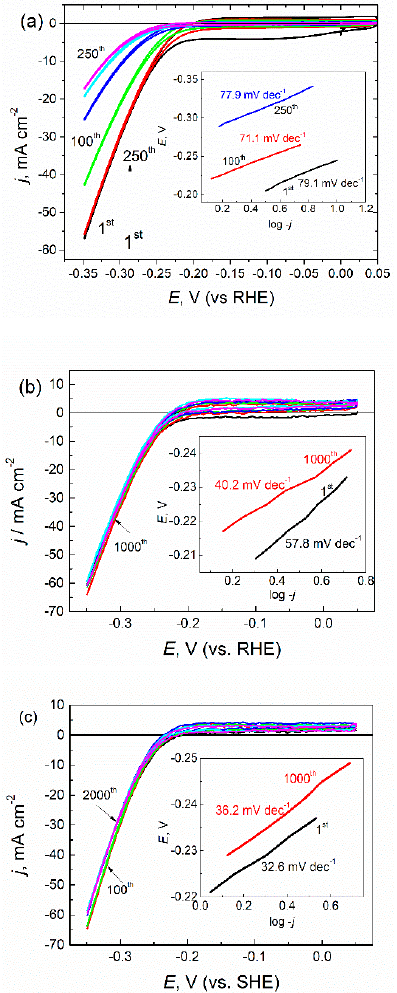
Figure 3. The sets of cyclic voltammograms recorded in the H 2 -saturated solution of 0.5 H 2 SO 4 mol L -1 at a 10 mV s -1 potential sweep rate of: ( a ) pure MoS 2 film and the same film hybridized with ( b ) 1.0 and ( c ) 3.0 mmol L -1 of L-cysteine. In the insets are the Tafel slopes calculated for the indicated specimen and the potential scan cycle.